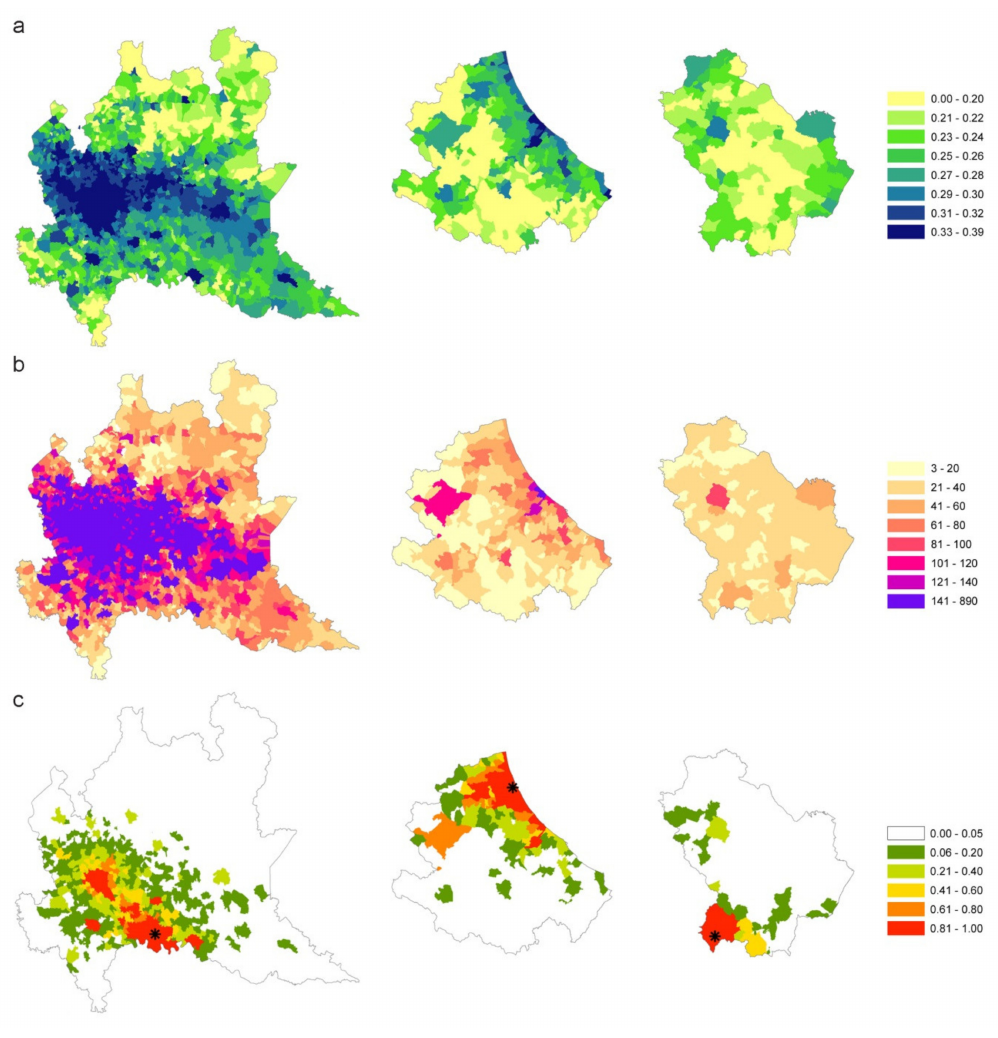
Figure 13. β values ( a ), degree measure ( b ) and estimated probability ( c ) of being infected for each municipality of high (Lombardy), medium (Abruzzi) and Low (Basilicata) a ff ected areas.